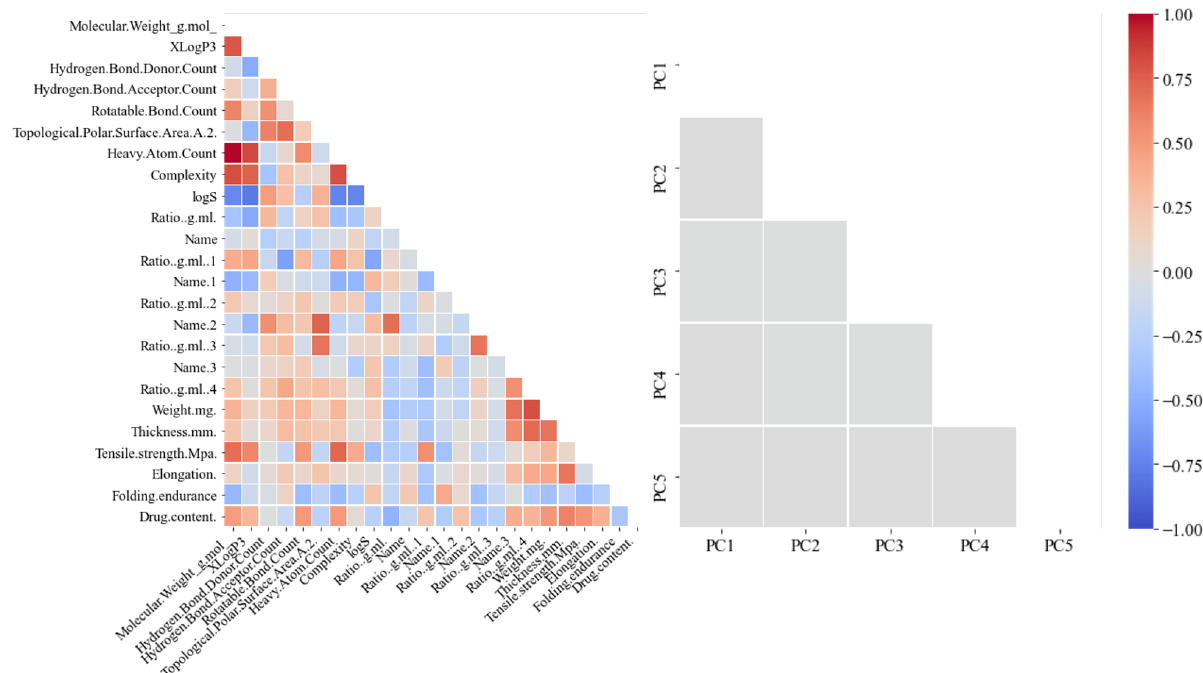
Figure 3. Correlation matrices of OFDF datasets before and after applying